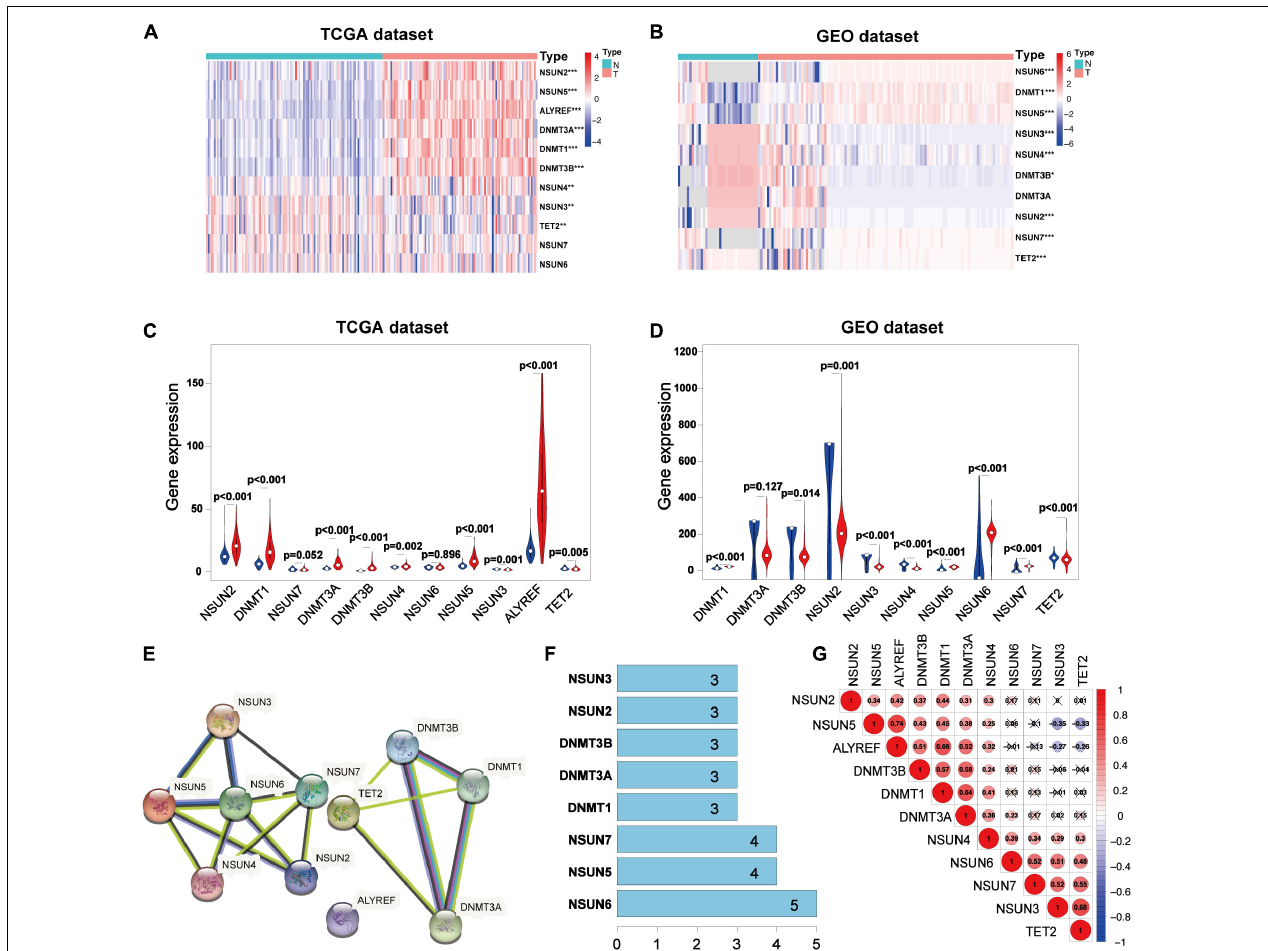
FIGURE 1 | Expression 3D models and correlation of m5C RNA methylation regulators in TNBC. Differential expression heatmap and violin plot of m5C RNA methylation regulators in TNBC and normal tissues from the Human Cancer Gene Atlas (A,C) and (B,D) Gene Expression Omnibus. The white dot in each “violin” represents the median expression. The PPI network of m5C RNA methylation regulators (E) , number of interaction nodes between m5C RNA methylation regulators (F) , and Spearman correlation analysis of m5C RNA methylation regulators (G) . * p < 0.05, ** p < 0.01, and *** p < 0.001. X indicates p > 0.05.N, normal sample; T, tumor sample; blue violin: normal sample; red violin: tumor sample; TNBC, triple-negative breast cancer; PPI, protein-protein interaction.